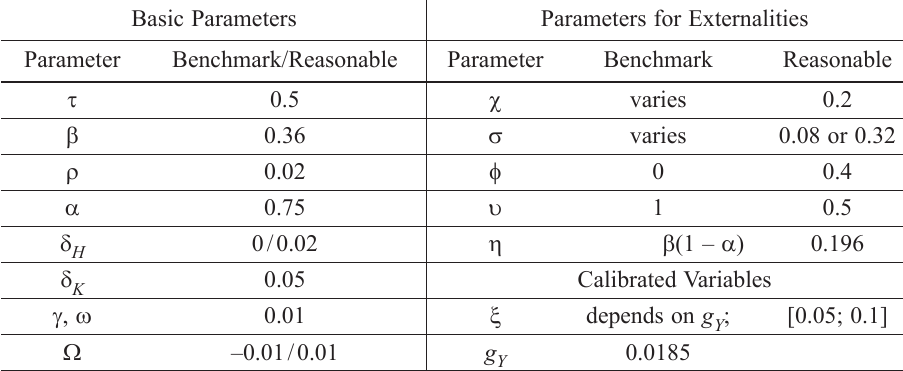
/ K ) DE and ( K / K ) * for different values S H S H